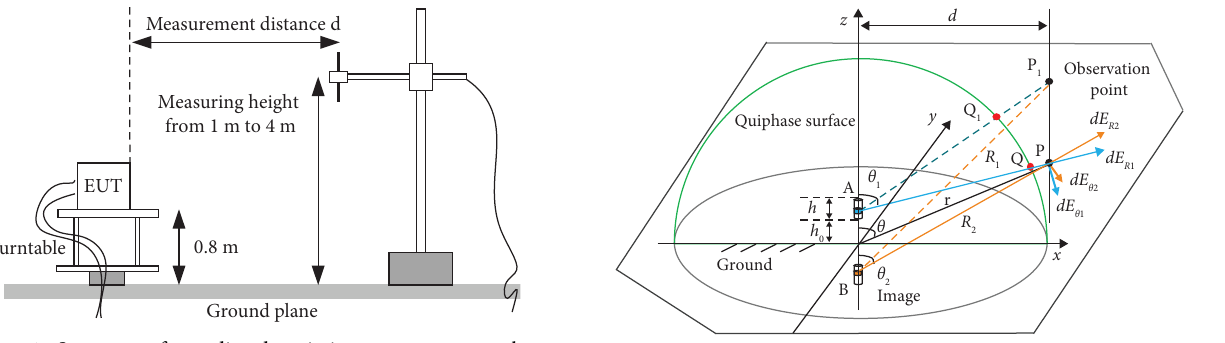
Figure 2: Calculation model of a vertical dipole above the PEC ground.